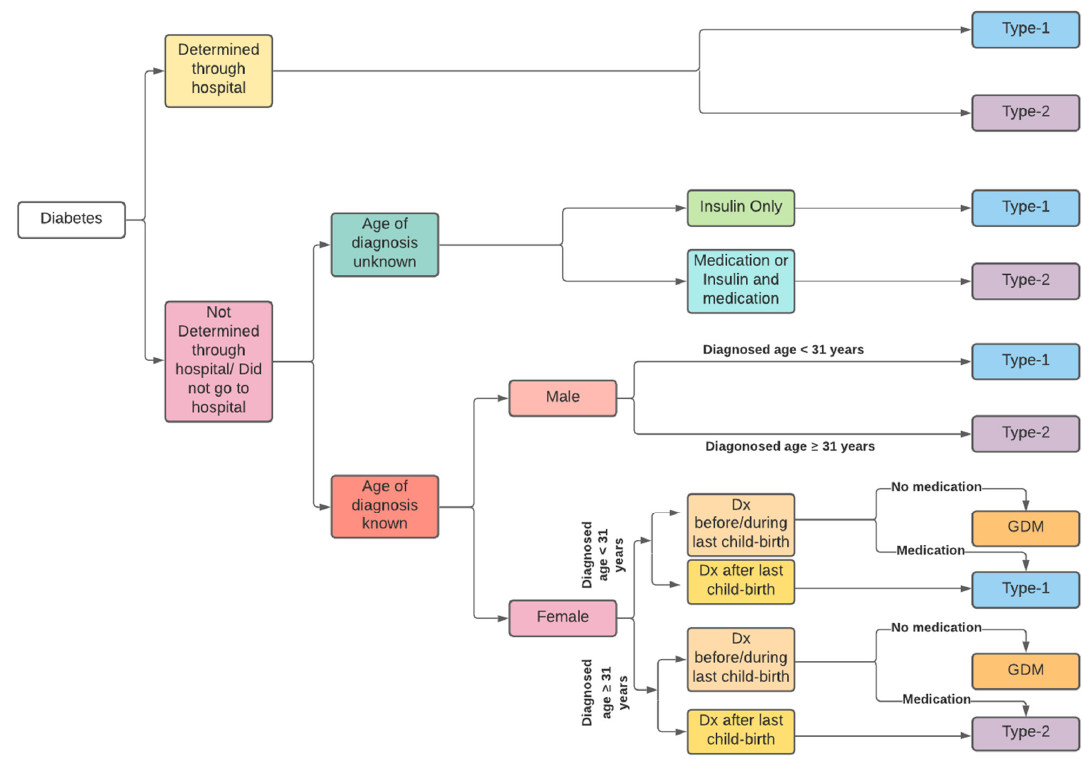
Figure 2. Identification of type of diabetes from the 45 and Up Study survey linked with health administrative data; Dx: diagnosed, GDM: gestational diabetes mellitus.